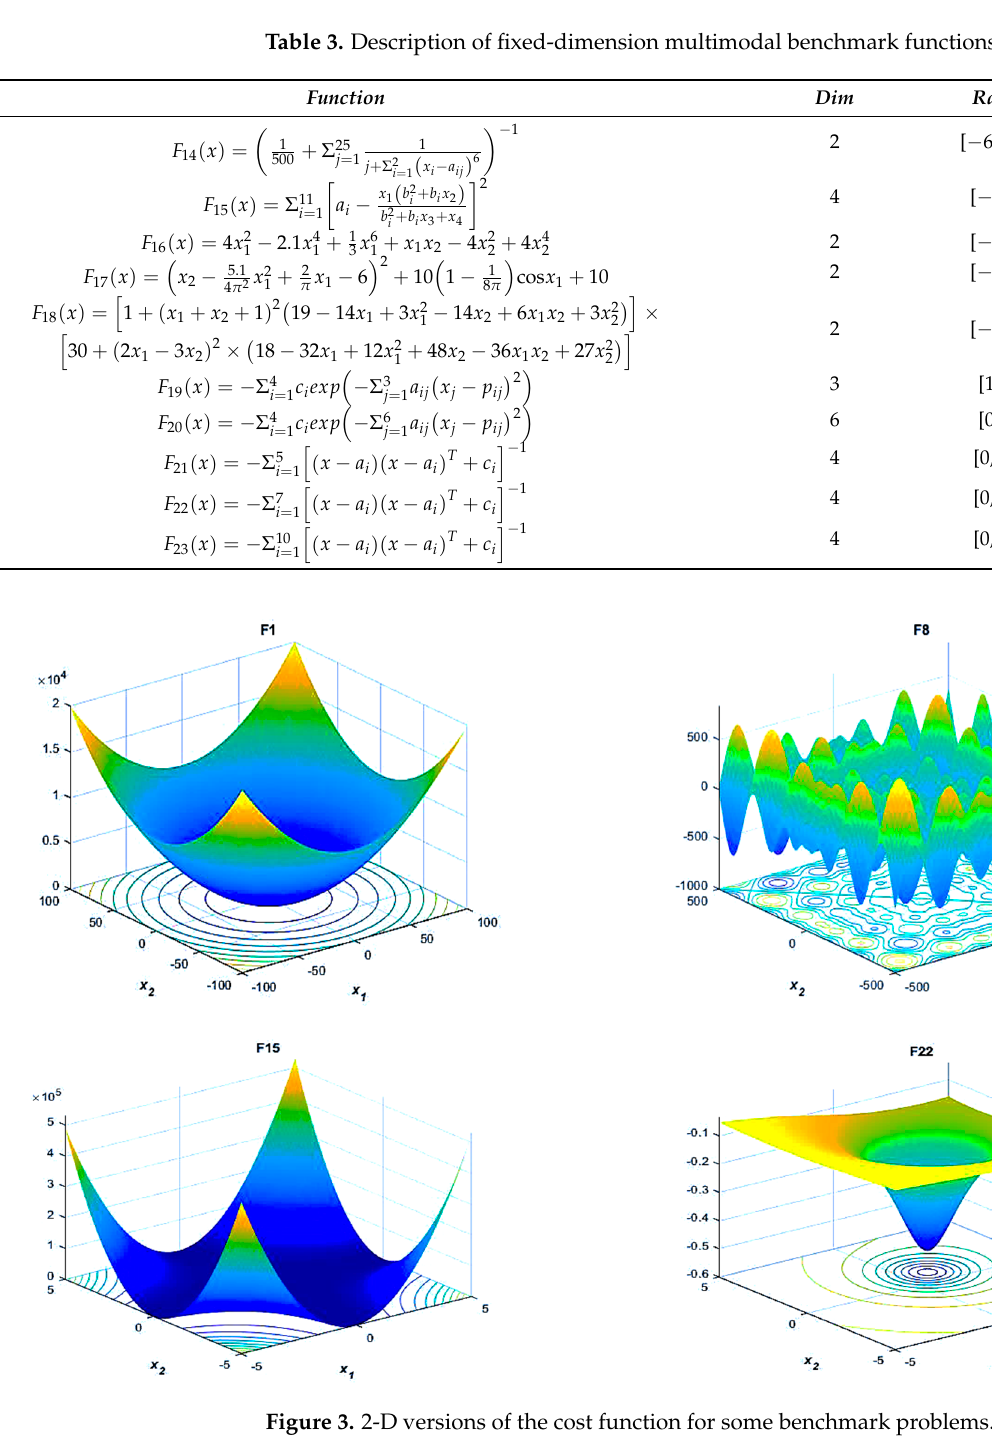
0 Table 3. Description of fixed-dimension multimodal benchmark functions ( (cid:1832) (cid:2869)(cid:2872) − (cid:1832) (cid:2870)(cid:2871) ). (cid:2162)(cid:2203)(cid:2196)(cid:2185)(cid:2202)(cid:2191)(cid:2197)(cid:2196)